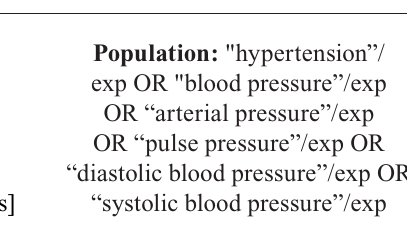
MeSH Emtree thesaurus